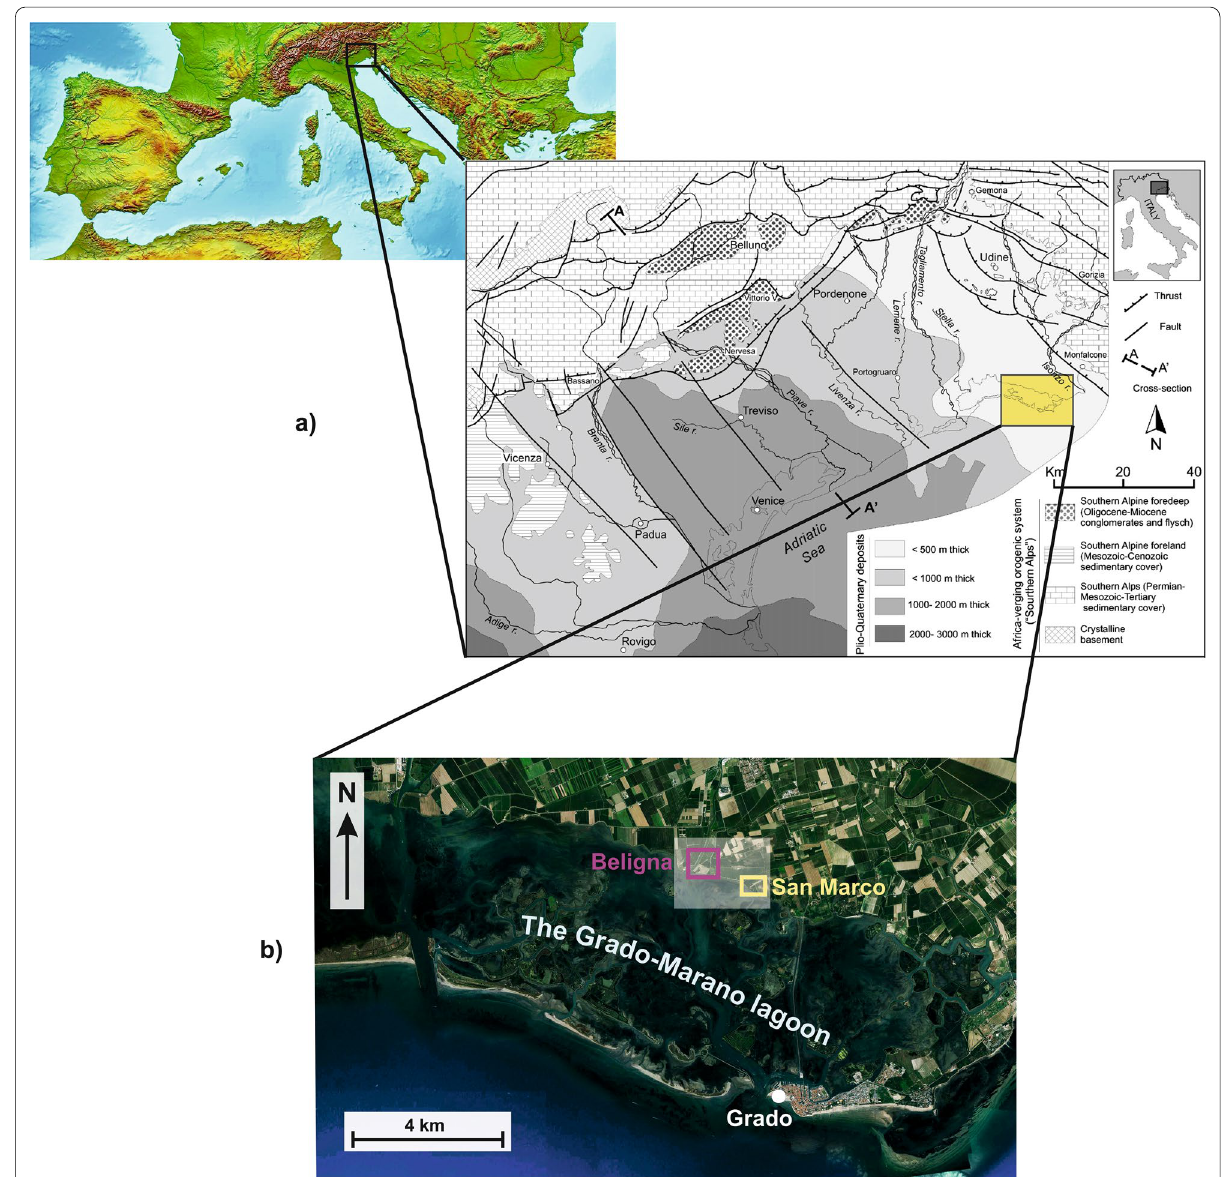
Fig. 1 Location of the investigated area: a general overview (South Europe map) and main geological, tectonic and alluvial elements (Fontana et al. 2008). The Grado-Marano lagoon is the area between the Isonzo and Tagliamento rivers; b study area with highlighted the Beligna and San Marco sites (see also Fig.